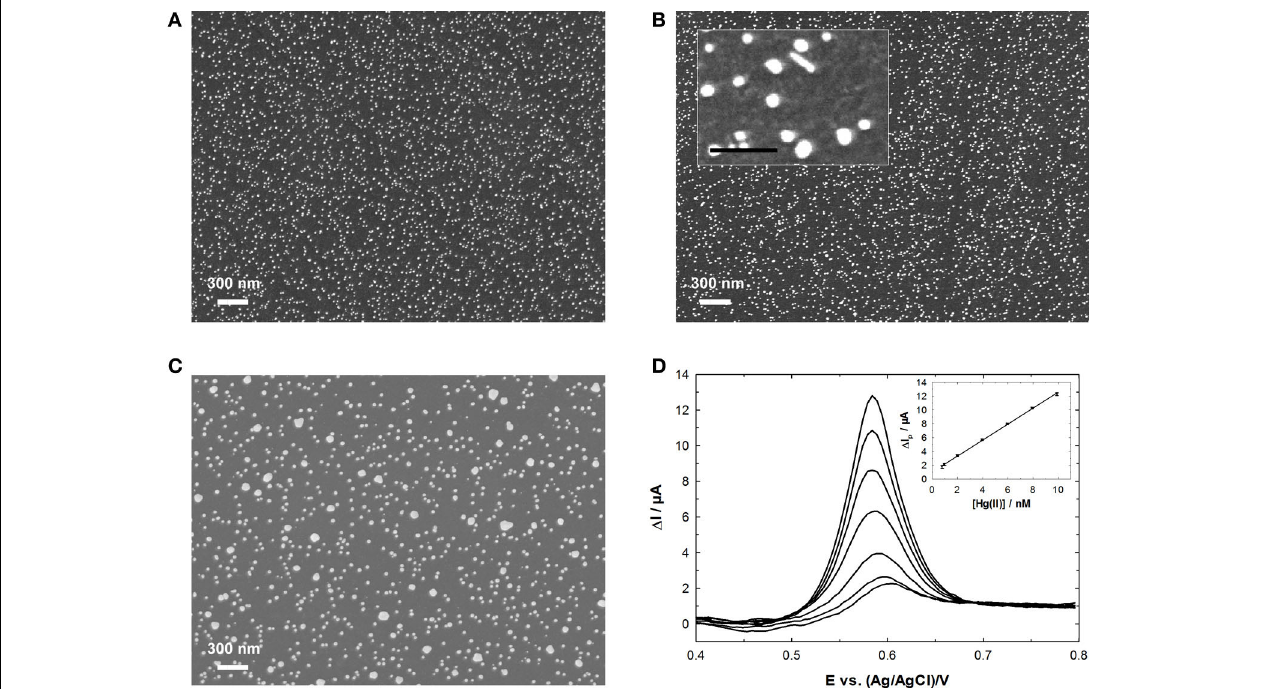
FIGURE 7 | AuNPs electrodeposited onto GC from a 0.25mM HAuCl 4 solution using: (A) chronoamperometry; (B) potentiostatic double pulse; (C) cyclic voltammetry. (D) SWASV response and calibration curve